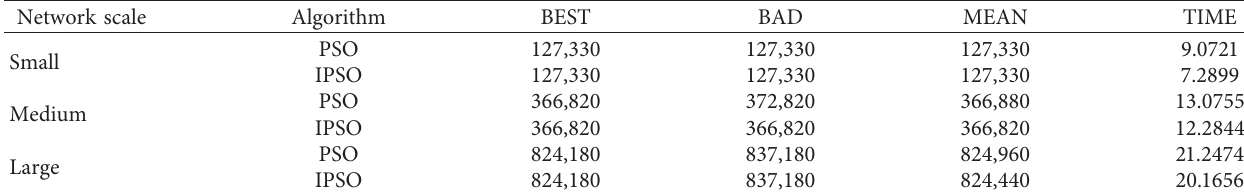
Table 13: PSO and IPSO performance in bulk cargo transport networks of different sizes.